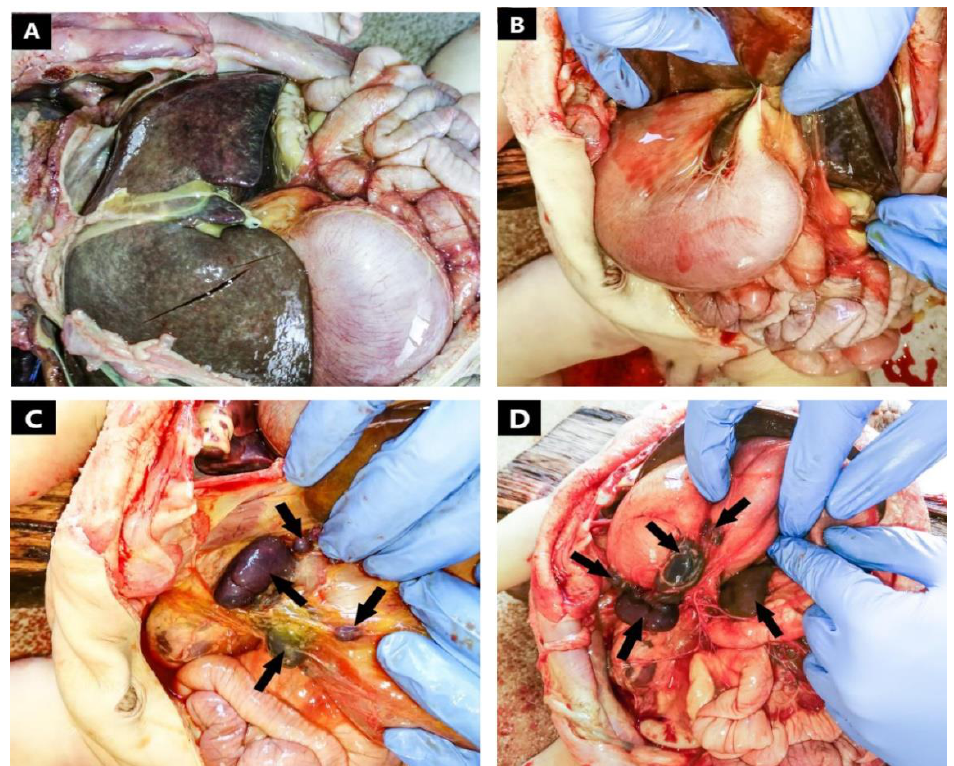
Figure 2. Macroscopic aspect of the abdominal cavity: ( A ) midline liver with almost symmetrical lobes; ( B ) right-sided stomach; ( C ) (arrows) multiple right sided spleens; ( D ) (arrows) multiple spleens among the greater curvature of the stomach.